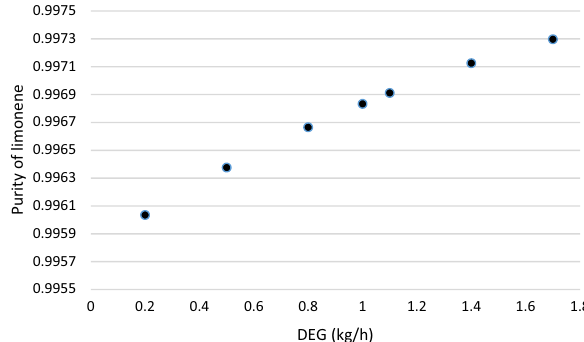
Figure 2. Effect of DEG amount on limonene